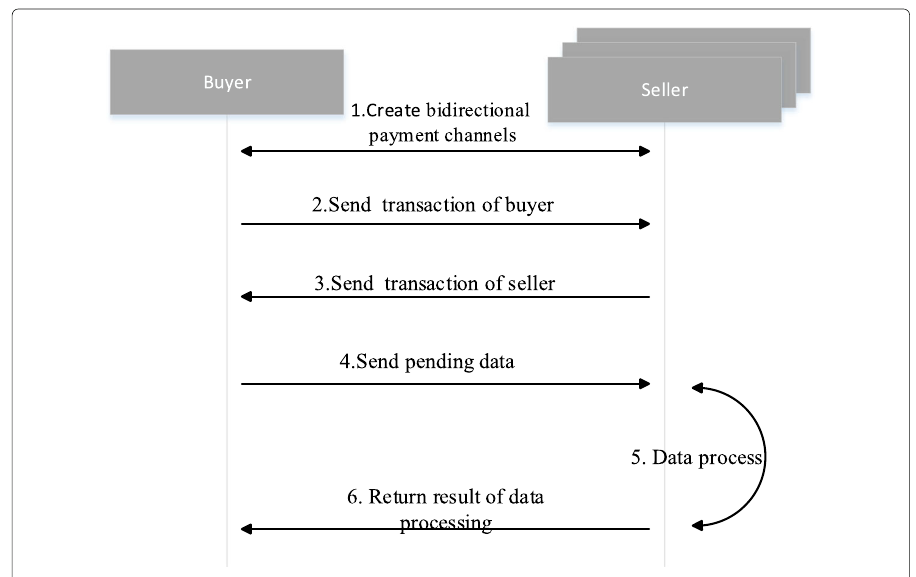
Fig. 5 The offline payment process